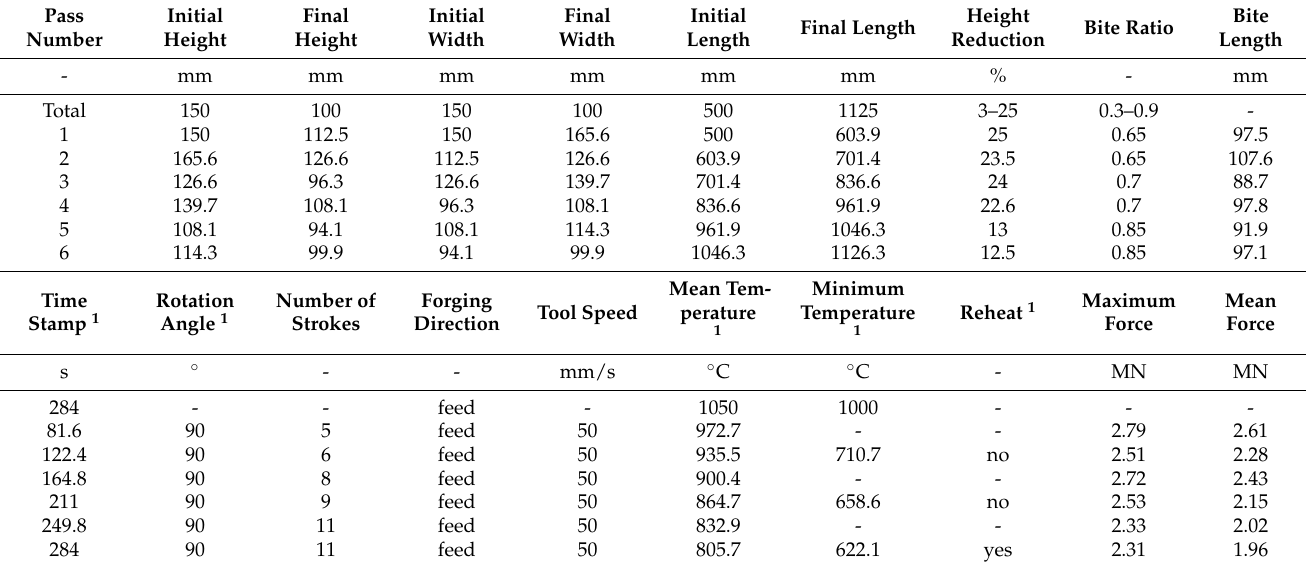
Table 5. Pass schedule of the experiment, generated with the adapted and retrained